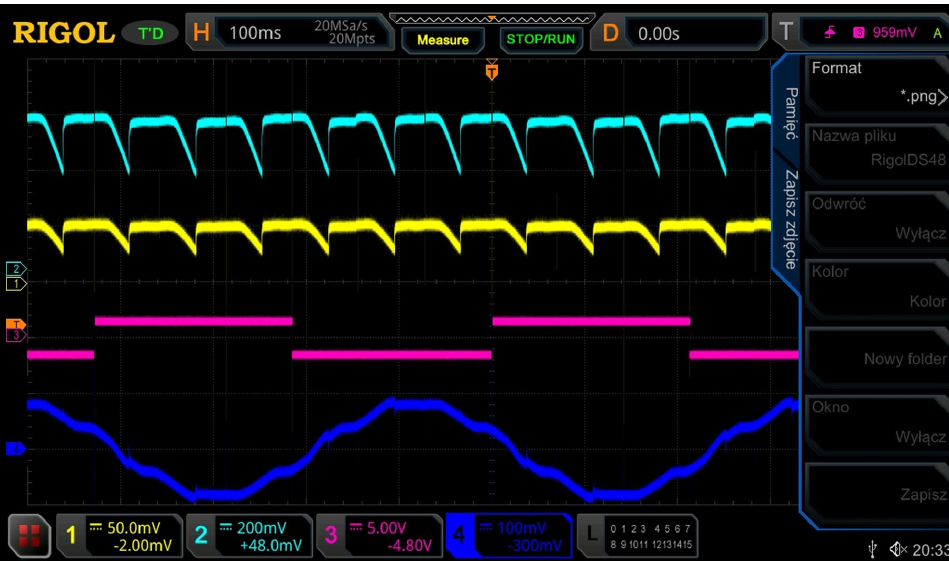
Figure 15. Current, voltage, synchronization signal and phase-to-phase voltage waveforms in the RMF rectifier.